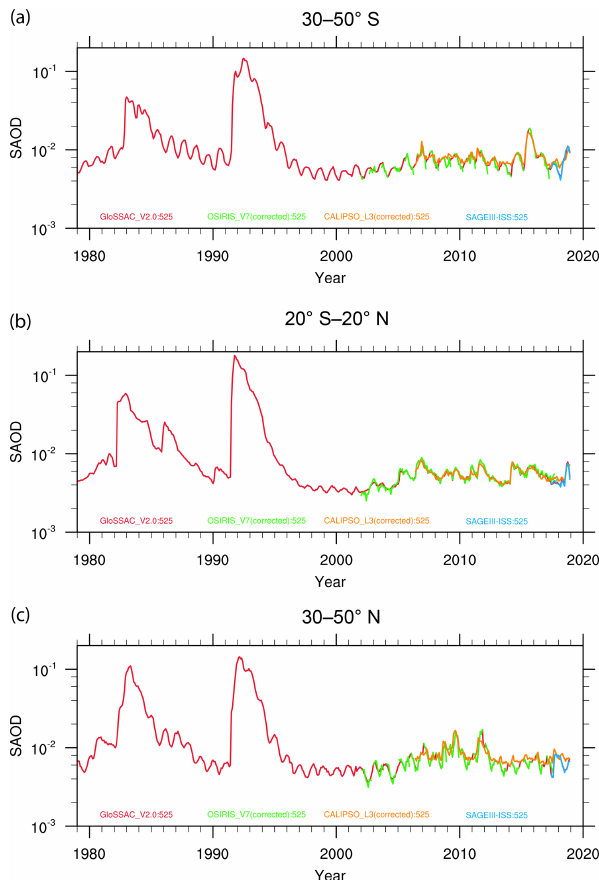
Figure 17. Zonally averaged monthly stratospheric aerosol opti- cal depth at 525nm for (a) 30–50 ◦ S, (b) 20 ◦ S–20 ◦ N, and (c) 30– 50 ◦